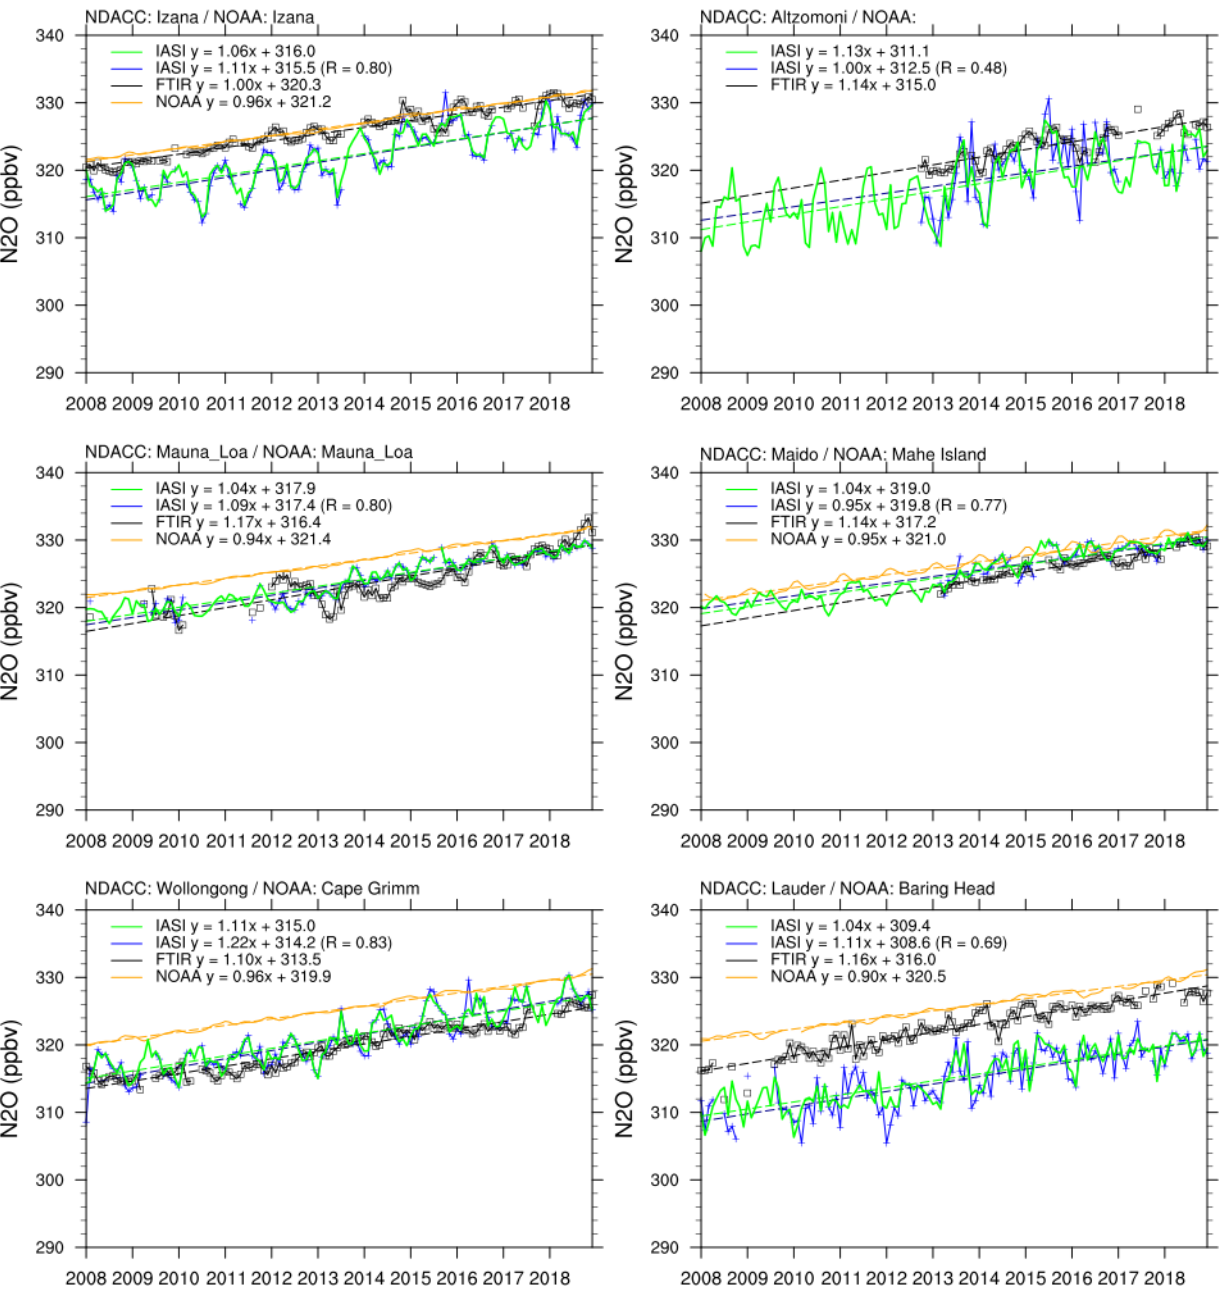
Figure 8. Same as Figure 7 at 6 NDACC stations for tropical and SH latitudes (Izana, Altzomoni, Mauna Loa, Maido, Wollongong,